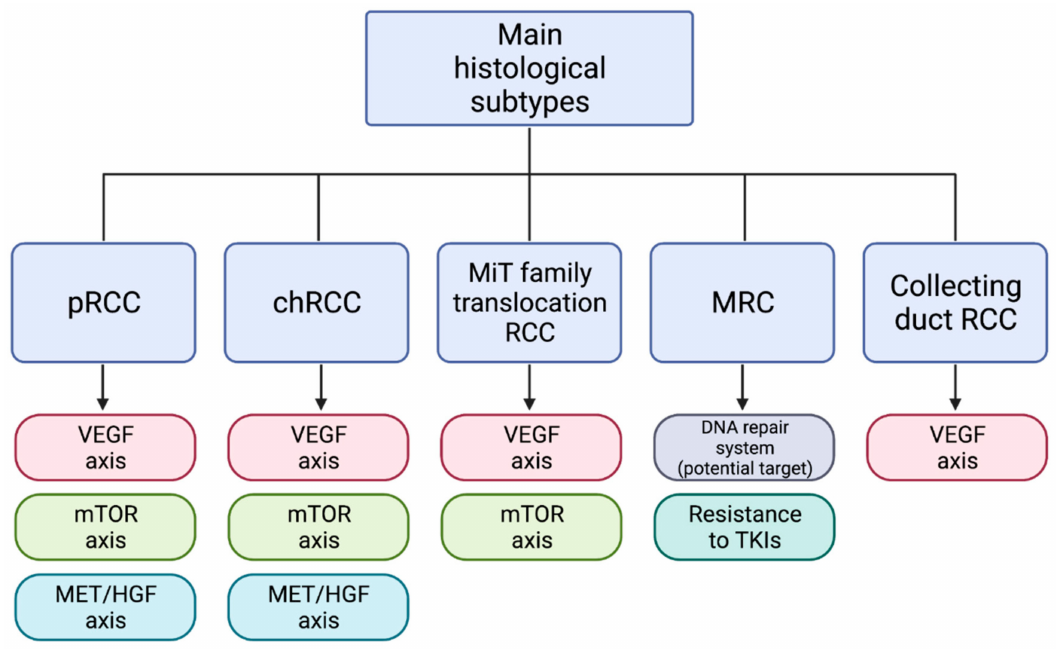
Figure 2. Workflow diagram of the molecular targets of the main histological subtypes of nccRCC. Abbreviations: pRCC = papillary renal cell carcinoma; chRCC = chromophobe RCC; MRC = medullary renal cell carcinoma; VEGF = vascular endothelial growth factor; mTOR = mammalian target of rapamycin; MET = mesenchymal epithelial transition or hepatocyte growth factor receptor; HGF = hepatocyte growth factor; TKIs = tyrosine kinase inhibitors. Created by BioRender.com (accessed on 8 June